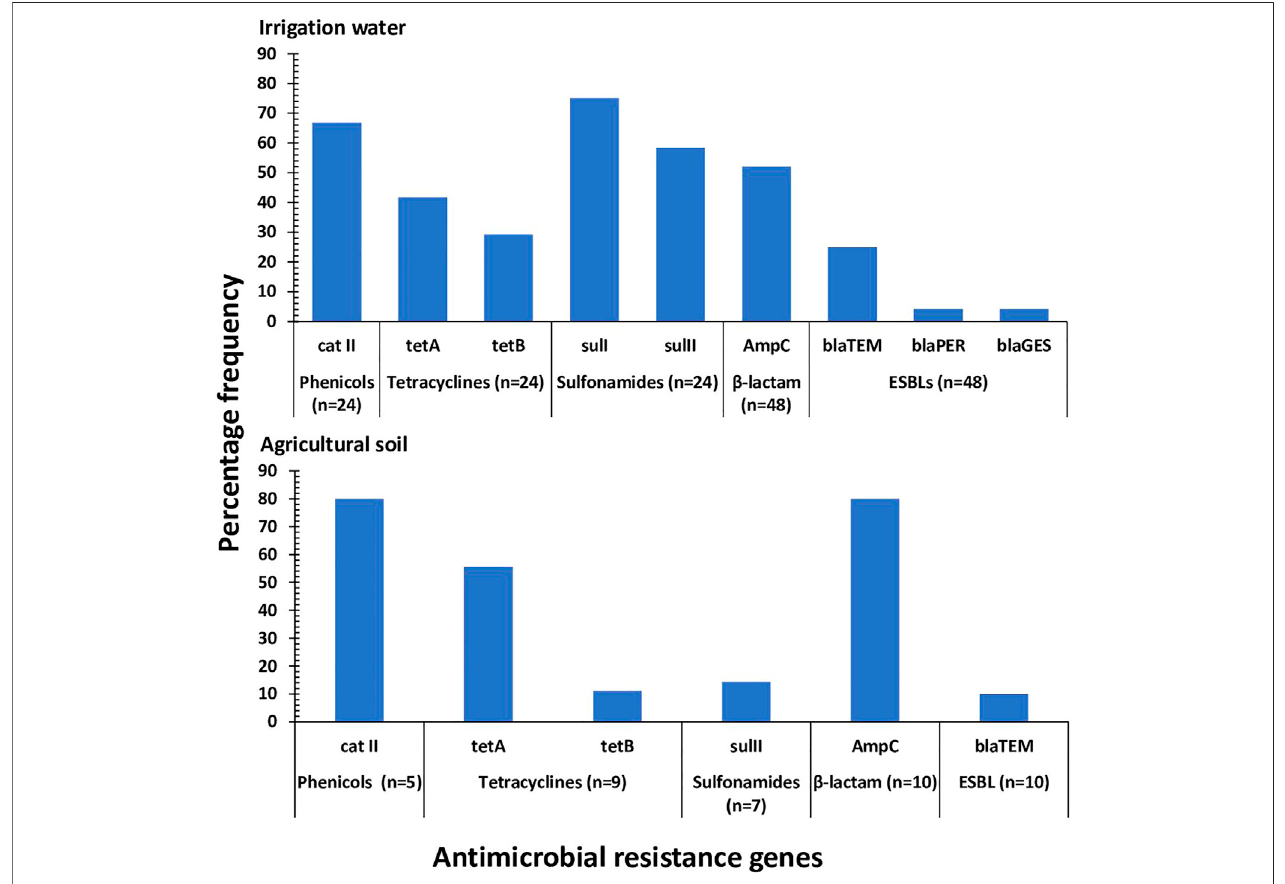
FIGURE5| ThefrequencyofoccurrenceofARGsdetectedinthepathogenicstrainsof E.coli recovered fromirrigationwaterand agriculturalsoil.n:thenumberof isolates phenotypically resistant against the associated antimicrobial.